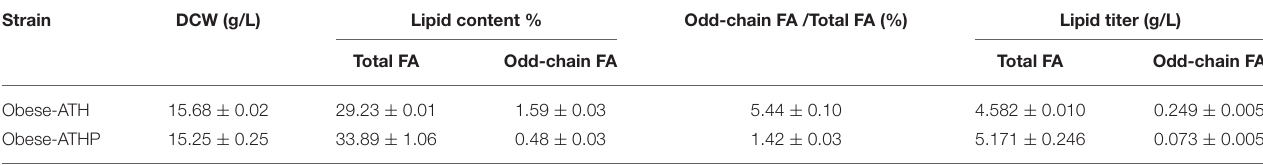
TABLE 5 | Fatty acid (FA) production in the obese-ATH strain and the obese-ATHP strain after growth on YNBD6 medium for 120h. Strain DCW (g/L) Lipid content % Odd-chain FA /Total FA (%) Lipid titer (g/L) Total FA Odd-chain FA Total FA Odd-chain FA Obese-ATH 15.68 ± 0.02 29.23 ± 0.01 1.59 ± 0.03 5.44 ± 0.10 4.582 ± 0.010 0.249 ± 0.005 Obese-ATHP 15.25 ± 0.25 33.89 ± 1.06 0.48 ±